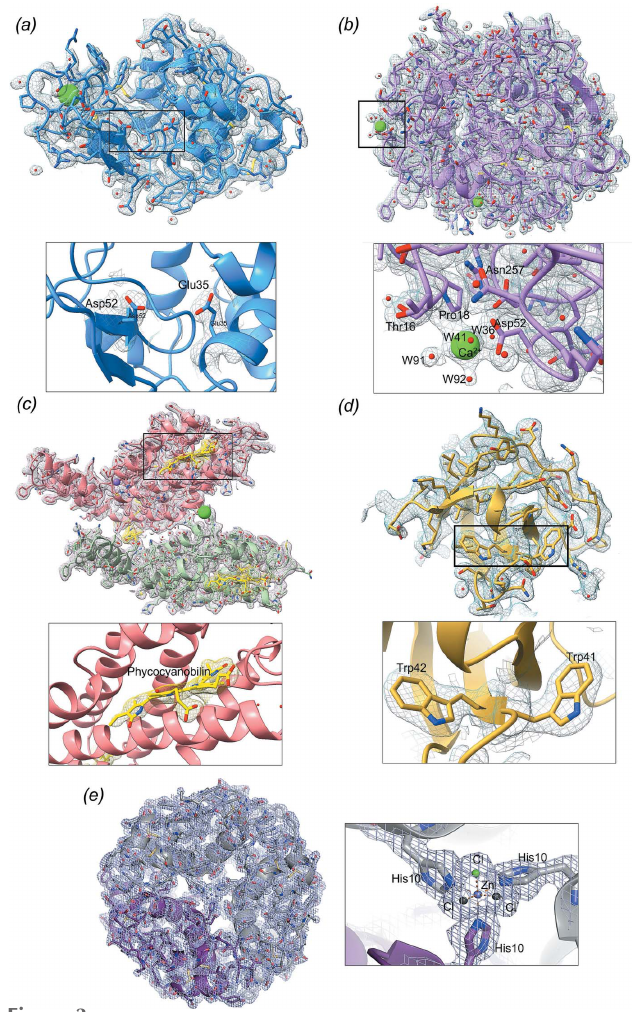
Figure 3 Quality of the 2mFo-DFc electron density maps for all structures tested contoured at 1 (cid:5) . ( a ) Lysozyme illustrated as a blue cartoon and stick representation. Solvent molecules (water in red) and Cl (cid:3) ions (green) are represented as spheres. A closer view (panel below) of the Glu35 and Asp52 residues at the catalytic site. ( b ) Proteinase K illustrated as a pink cartoon and stick representation. Solvent molecules (water in red) and the Ca 2+ ion (green) are represented as spheres. A closer view (panel below) of one of the Ca 2+ ions. ( c ) The two phycocyanin subunits ( (cid:2) green and (cid:3) salmon) illustrated as a blue cartoon and stick representation. The chromophores are shown in a yellow cartoon and stick representation. Solvent molecules (water in red), Na + ions (purple) and Cl (cid:3) ions (green) are represented as spheres. A closer view (panel below) of the phycocyanobilin chromophore. ( d ) The (cid:2) -spectrin-SH3 domain illu- strated as a yellow cartoon and stick representation. Water molecules are shown as red spheres. A closer view (panel below) of the Trp41 and Trp42 residues at the binding site. ( e ) Hexameric human insulin illustrated as a cartoon and stick representation. The dimer in the asymmetric unit is shown in purple and symmetry-related molecules are shown in dark grey. A closer view (right panel) of the coordination of the Zn 2+ ion (blue) with the His10 residues (sticks), and the Cl (cid:3) ions (in green, and black for the symmetry-related